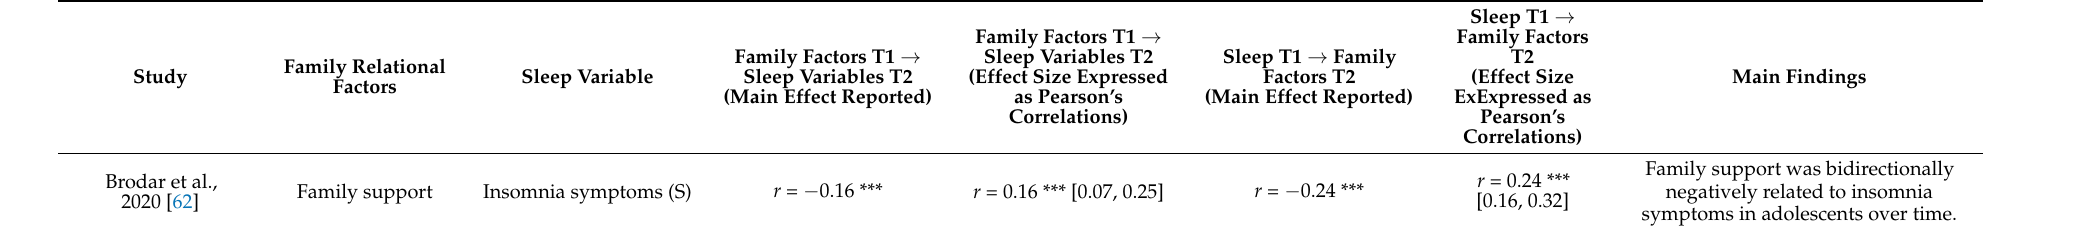
Table 3. The Interplay Between Positive and Negative Family Relational Aspects and Adolescents’ Sleep